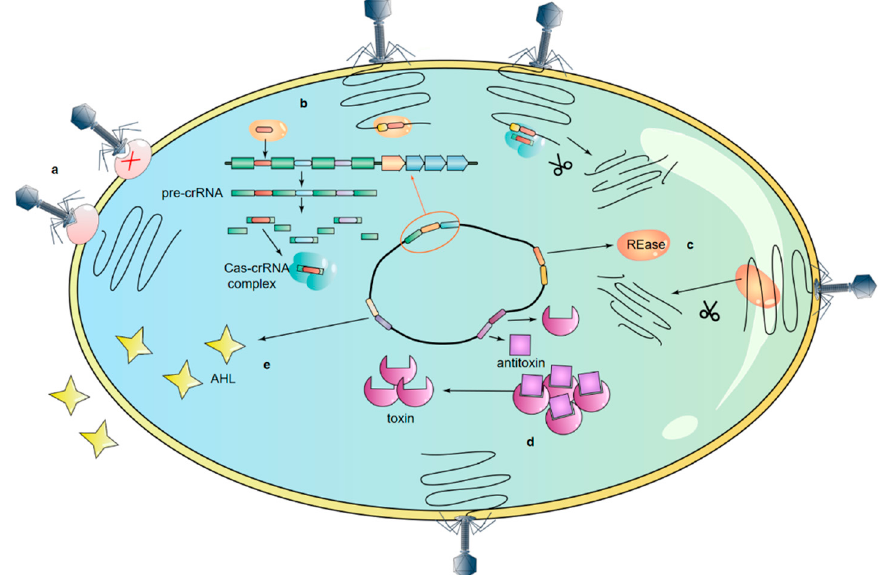
Figure 5. Bacteriophage resistance mechanism of A. baumannii . (a) Adsorption inhibition. Inhibition of phage adsorption by receptor deletion or structural change. (b) Inhibition of phage replication by CRISPR-Cas. (c) Restriction enzyme (REase) in the restricted-modification (R-M) system recognizes unmethylated phage genes and cleaves them. (d) The toxins in the toxin–antitoxin (TA) system can mediate abortive infection (Abi), and thus exert anti-phage effects. (e) A. baumannii resists phage infection through n-acyl-homoserine lactone (AHL) in quorum sensing (QS).